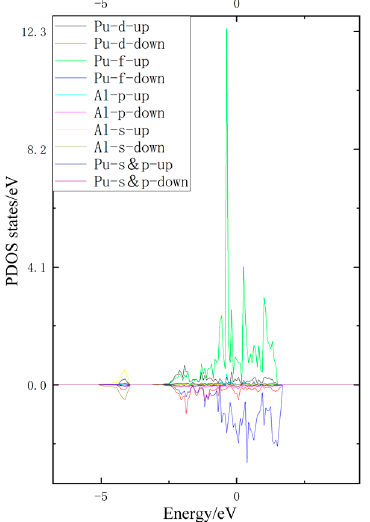
Figure 10. PDOS of Pu-Al system (near the Fermi level).